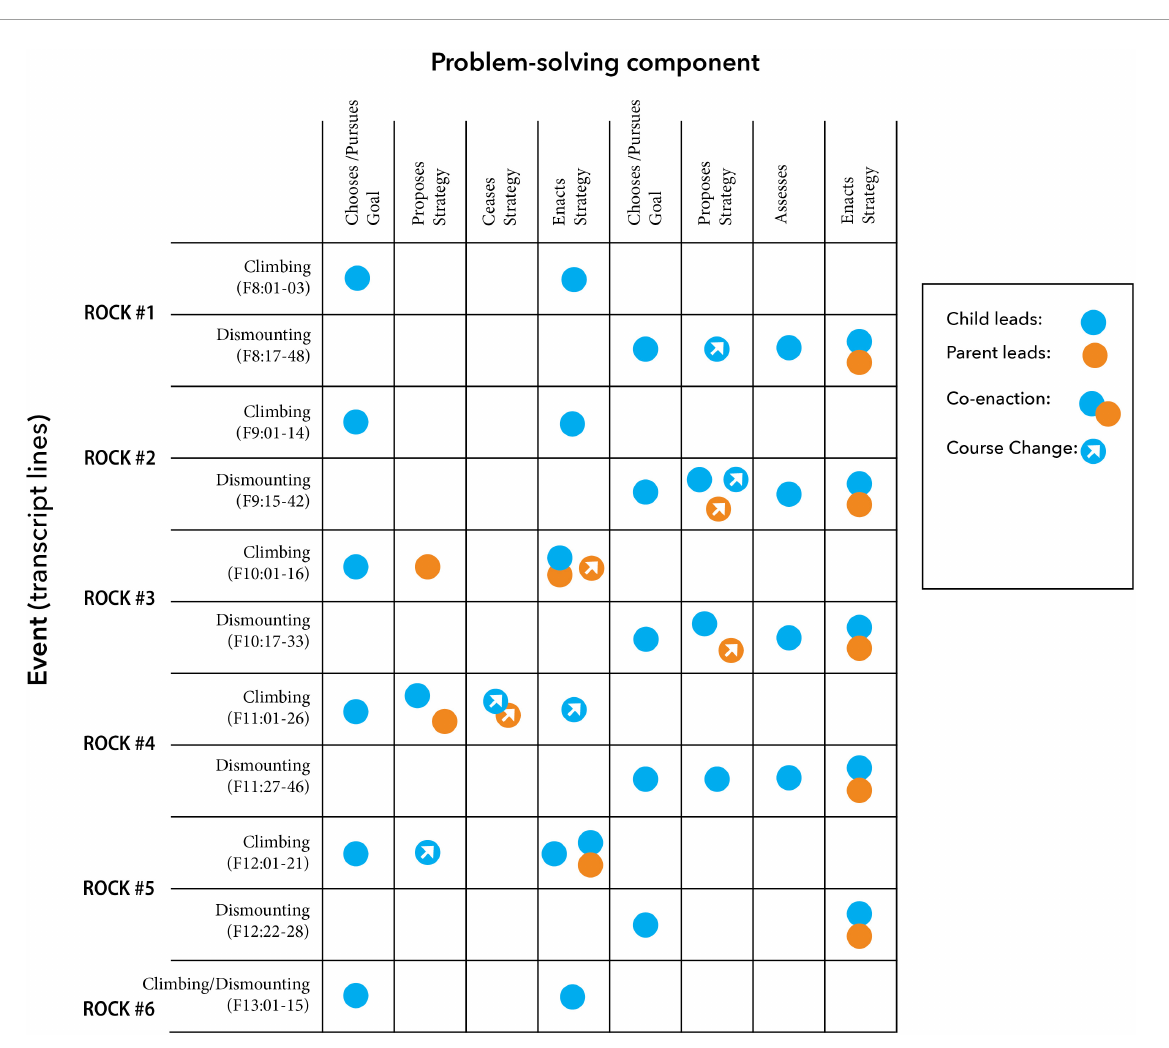
uneven surfaces of the rocks, even playfully narrating “ who:a (.) they’re slipping ” (F8:16) on Rock #1. In a more subtle moment of support, Mom responds to a request for dismount help on Rock #3 by leading Jaz down the slope to a lower end of the rock, but offers only a passive hand, creating a space where Jaz is supported if needed, but still has to navigate the slope largely under her own power. Along similar lines, Mom displays a pattern of preserving challenges even when she assents to the request for help. On the dismounts from Rock #’s 1 through 3, we see Mom offer a passive version of the “hand holding” Jaz requests, extending an open hand while maintaining a bit of distance from her child, allowing Jaz to grab onto it while stepping down and negotiating the landing and balancing largely on her own. On the first rock, Jaz can be seen to reach for an assist with her other hand as mom is stepping away, leaving Jaz to grasp at air, and partially lose her